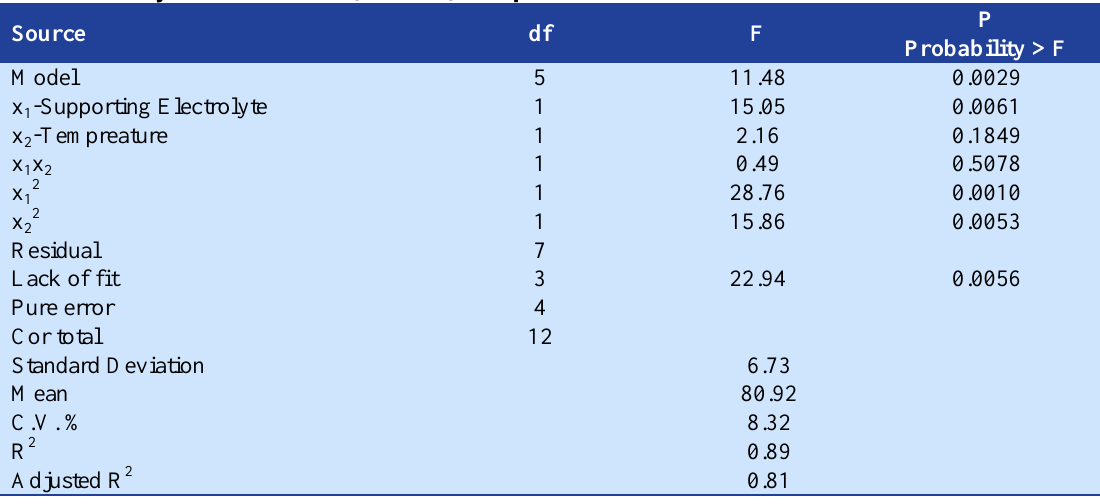
Figure 3. Ammonium variation via reaction time Table 3. Analysis of variance (ANOVA) for quadratic